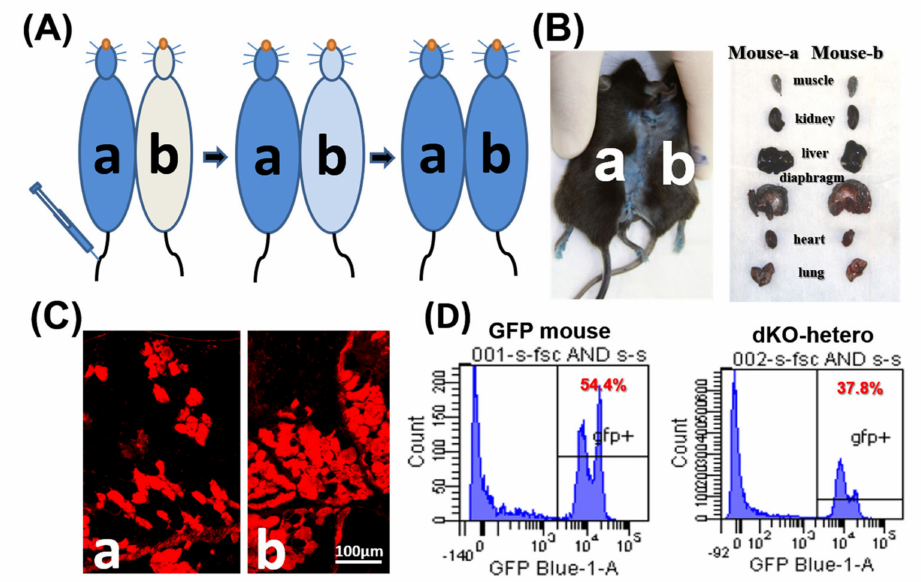
Figure 1. The establishment of parabiotic models. ( A ) Mdx (a) and dKO-hetero mice (b) were joined surgically via parabiosis. Two weeks after surgery, Evans blue (350 µ L) were injected into the tail vein of mdx mice (a). ( B ) 20 h after injection, both mice showed blue stain on their skin and internal organs. ( C ): Gastrocnemius muscles were sectioned and fluorescence signal (red) of Evans blue that leaked into the damaged myo-fibers were detected in both dystrophic mice. ( D ): WT-GFP mice were joined with dKO-hetero mice surgically via parabiosis for 2 weeks. Peripheral blood was collected and depleted with the red blood cells. GFP signals were tested via FACS. Mixed GFP ( − ) and GFP (+) cells were detected in the peripheral blood of each partner in dKO-hetero/GFP mice pairing demonstrating shared circulating between paired